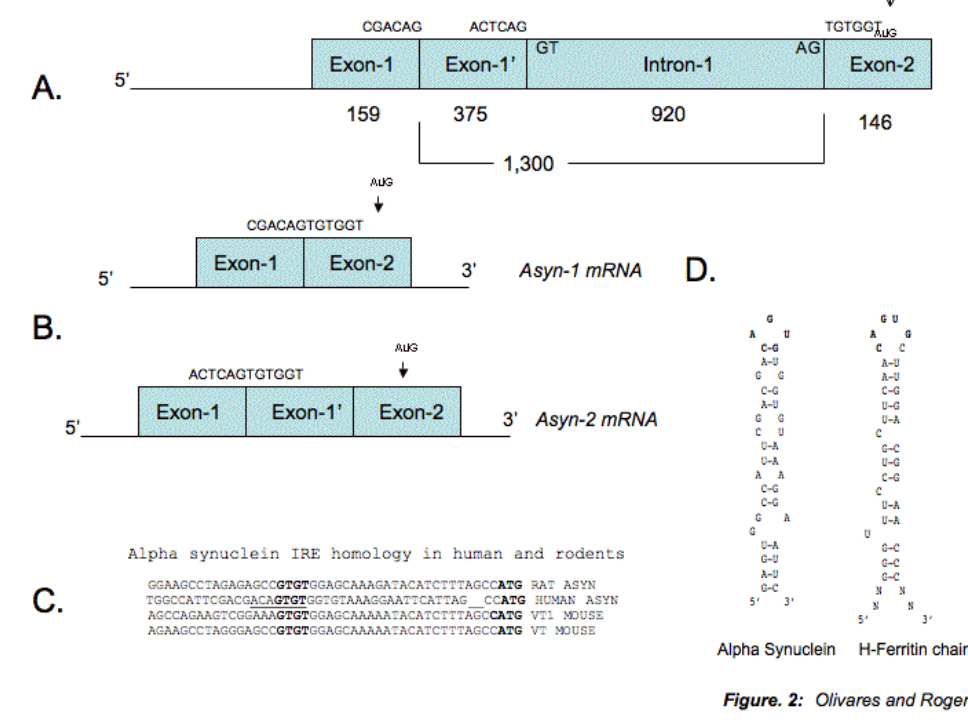
Figure 2. An RNA Stem loop is predicted within 5' Untranslated region (5’UTR) of the Parkinson’s disease alpha synuclein ( α -syn) transcript that is homologous to the Iron- responsive element (IRE) in H-ferritin